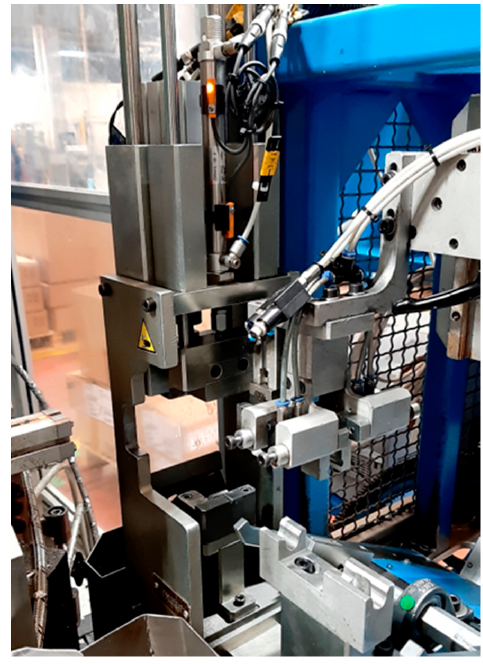
Figure 7. Machine to remove the sprues from the cable terminals.